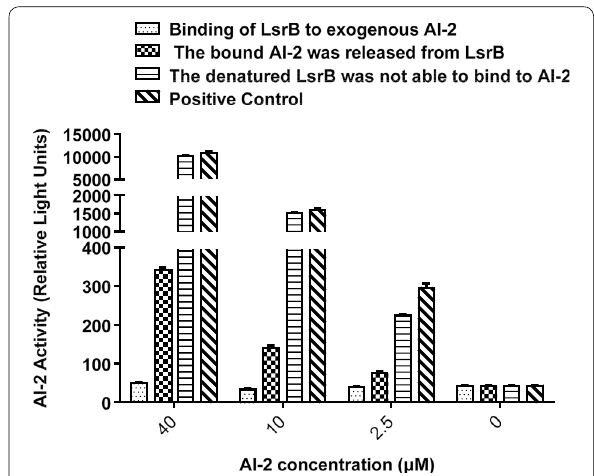
Fig. 6 Binding of LsrB to exogenous AI-2. Different concentrations of AI-2 (2.5, 10.0 and 40.0 μM) were incubated with 5 mg/ml of LsrB (BL21∆luxS). The results of AI-2 binding activity indicated that 5 mg/ ml of LsrB (BL21∆luxS) could bind exogenous AI-2 from 2.5 to 40 μM. Furthermore, the assay of AI-2 releasing activity showed that bound AI-2 was released from LsrB (BL21∆luxS) at 55 °C for 10 min. However, denatured LsrB (BL21∆luxS) was not able to bind to